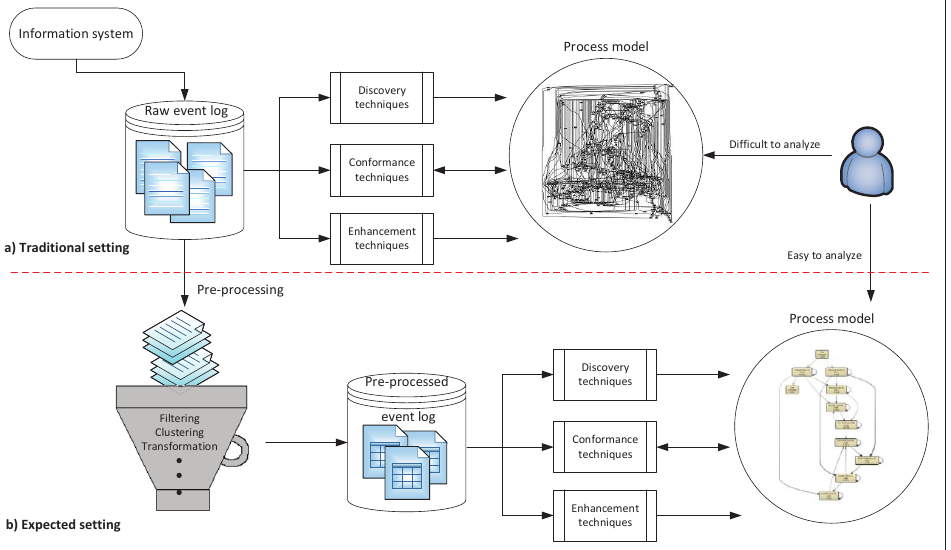
Figure 1. Overview of the traditional and expected process of applying data mining techniques using a raw event log and preprocessed event log,